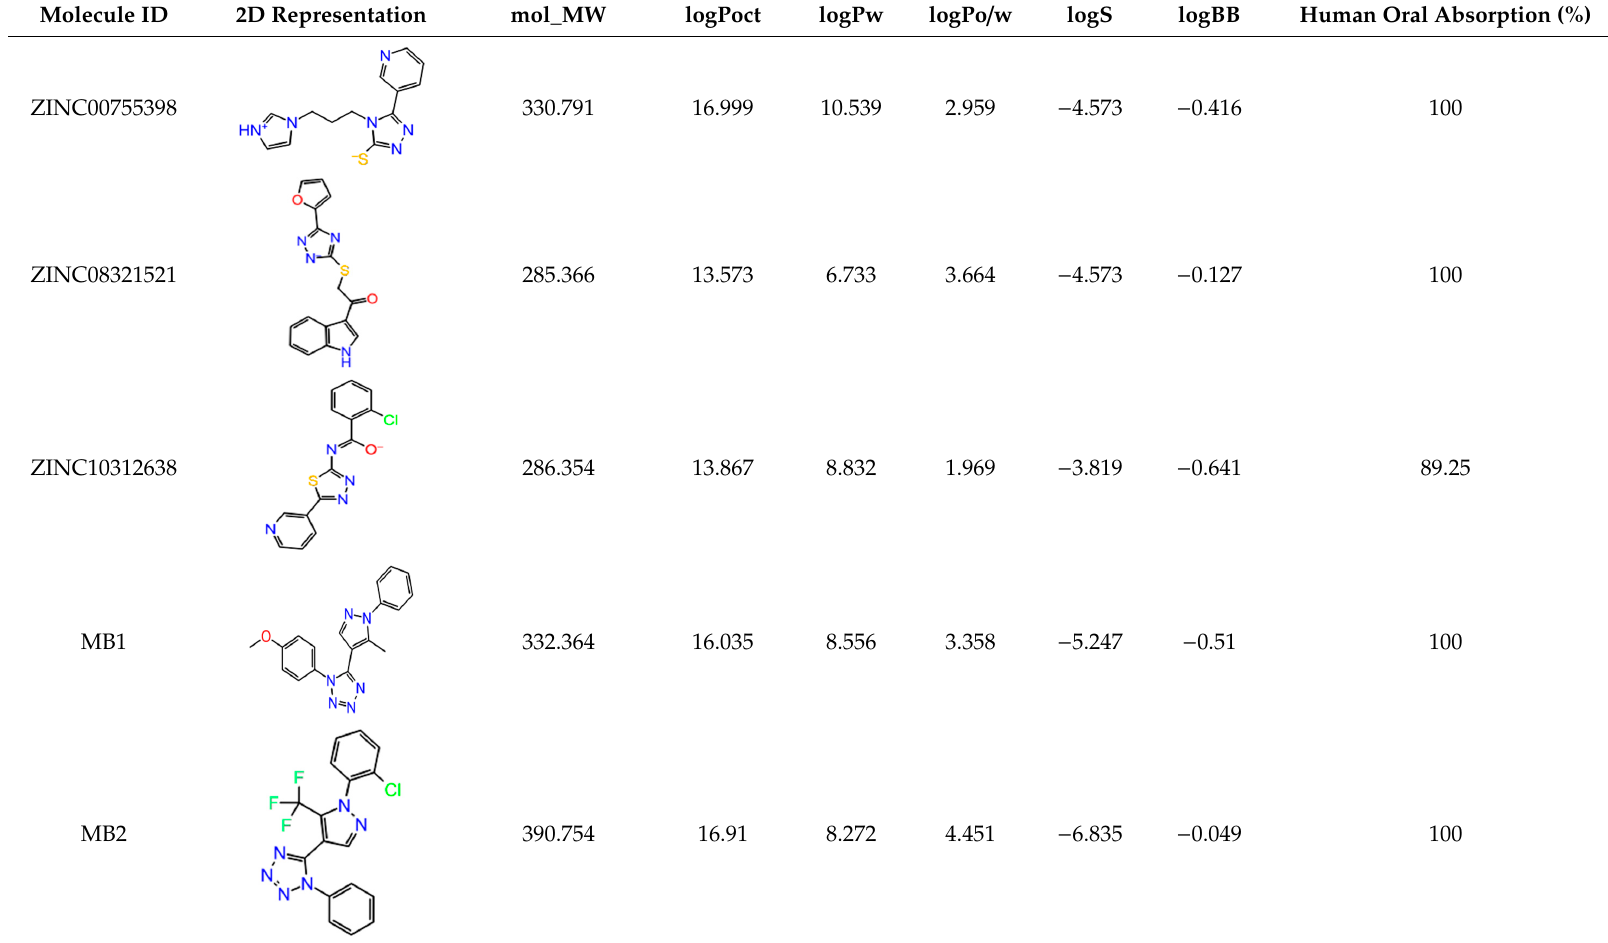
Table 5. Top 5 hit compounds obtained from ZINC and Maybridge databases filtered using QikProp program.